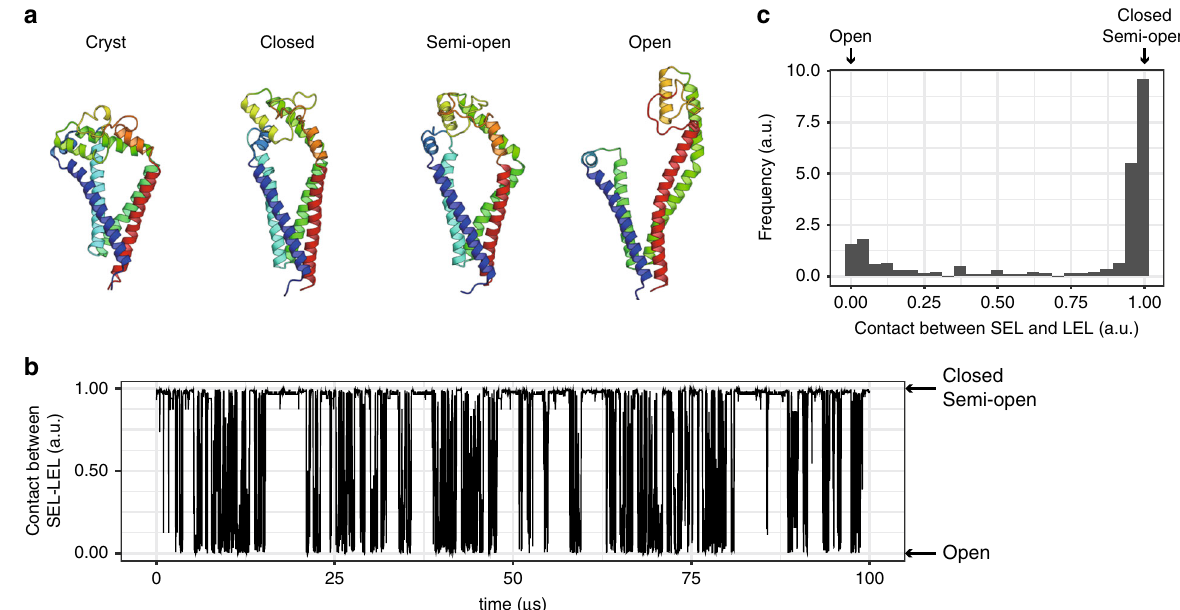
Fig. 3 MD simulation of CD9. a Structural comparison between the crystal structure (Cryst) and the three major conformations in the MD simulation (Closed, Semi-open, and Open). b Time course of the contacts between the SEL and LEL in the reconstructed 100 μ s trajectory. The value of 1 corresponds to the shorter distance between the SEL and LEL, and the value of 0 corresponds to the longer distance between the SEL and LEL. For the detailed de fi nition of the contacts between the SEL and LEL, see Methods section. c Distribution of the contacts between the SEL and LEL in the longer reconstructed trajectory, corresponding to the 15 ms time